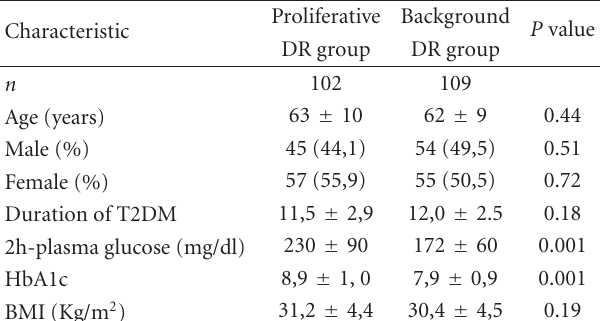
Table 1: Clinical characteristics of type 2 diabetic patients.